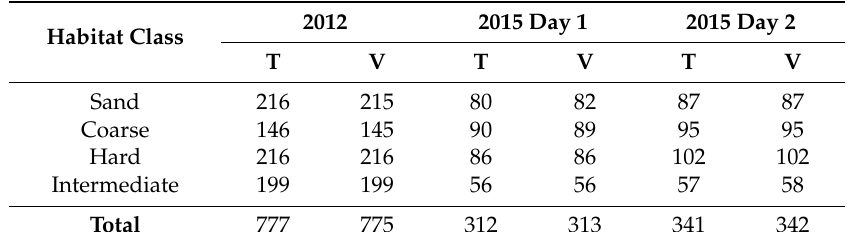
Table 3. Groundtruth data, as the number of image tiles (mosaics of five consecutive images) used to groundtruth the sidescan sonar classifications, separated into training (T) and validation (V) sets by year and survey day [28]. Images to groundtruth the 2012 classification were taken in 2012, all images to groundtruth the 2015 classifications were acquired during one AUV mission in 2015.